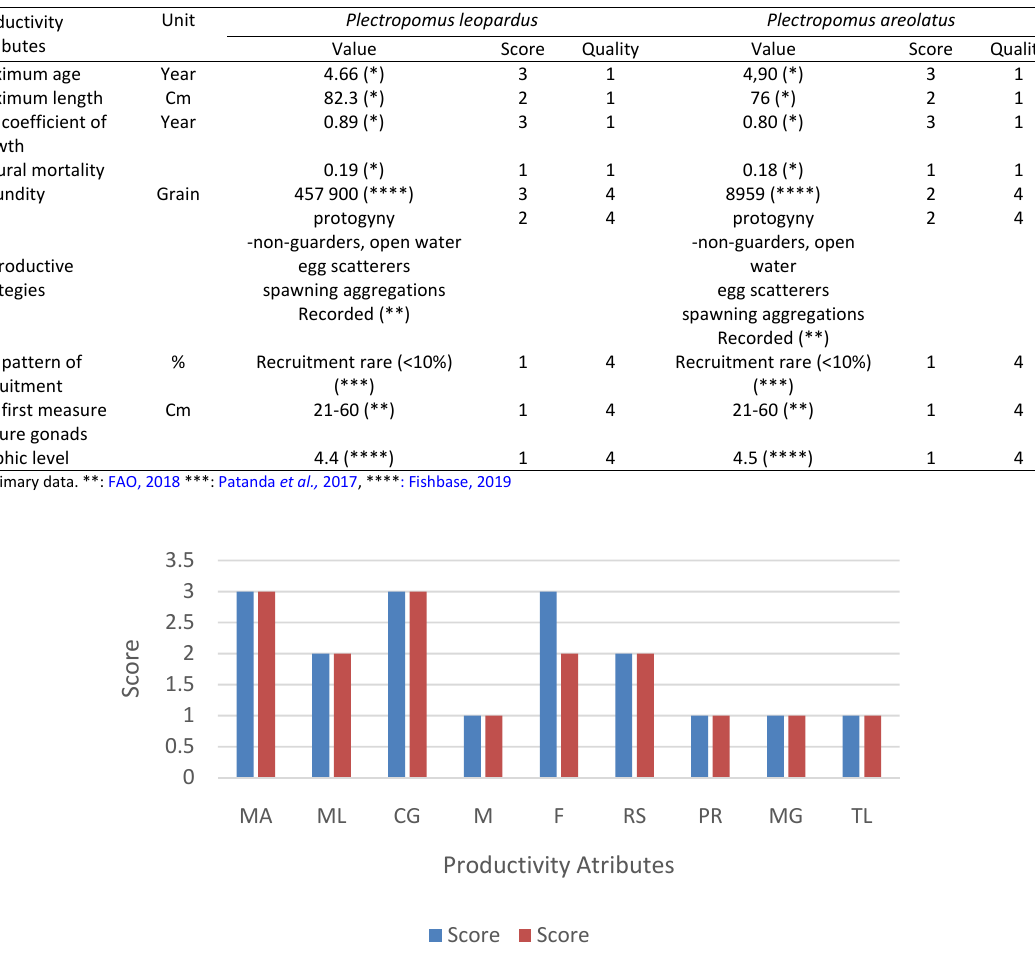
Fig. 3: Score of Plectropomus areolatus and Plectropomus leopardus based on Productivity